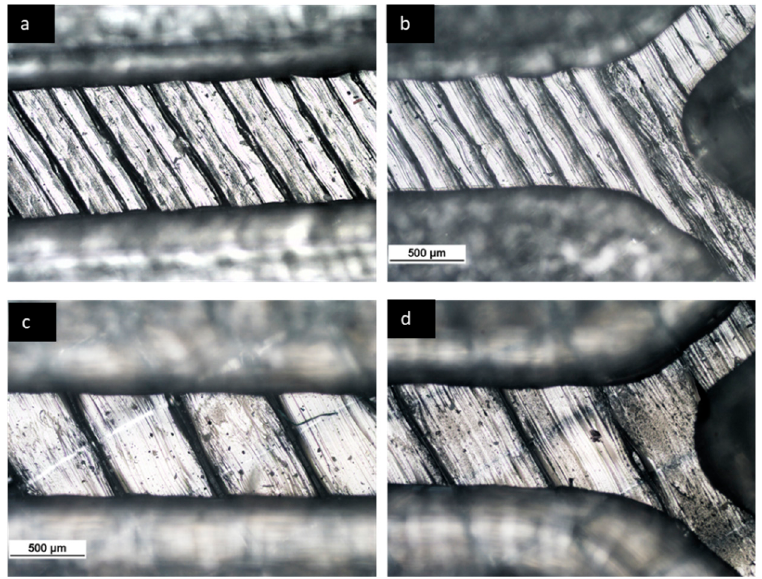
Figure 3. Photographs of different fabricated channels: ( a , b ) show the fabricated device with a line width of 200 μ m; ( c , d ) show the fabricated device with a line width of 600 μ m. Table 2. Factors and levels.